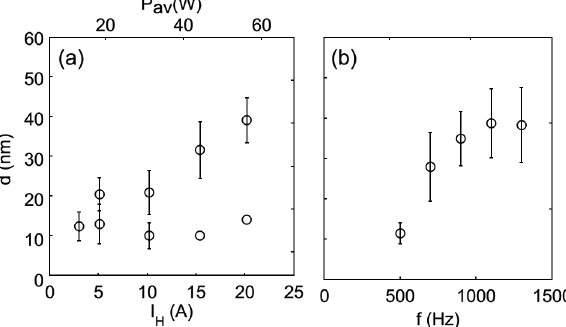
Fig. 8 Variation of the size of copper nanoparticles by chang- ing a pulse parameter: ( a ) peak current (energy per pulse) and ( b ) frequency at constant average power.